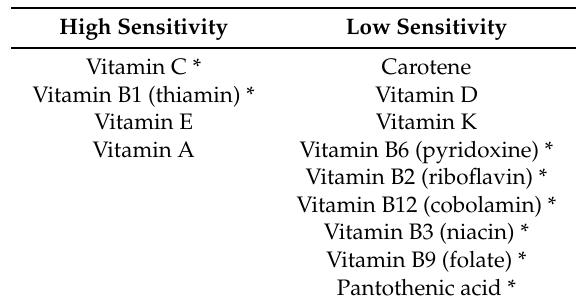
Table 2. Relative sensitivity of vitamins to